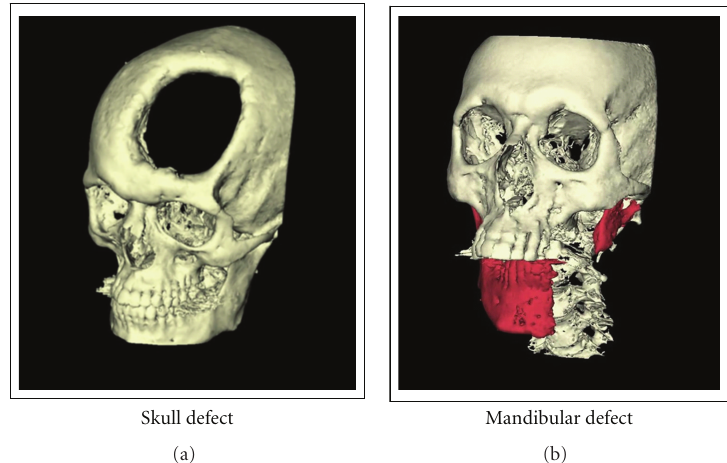
Figure 1: 3D reconstruction of a skull and mandibular defect in trauma patients. Surgeons are often faced with patients having large defects in the bone which do not heal spontaneously. The gaping hole in the skull and the area highlighted in red in the mandible are examples of large-sized defects in real patients. Though autografts are the gold standard treatment for such patients, the amount of graft material required is often the limiting factor. Tissue regeneration using synthetic or natural sca ff olds seeded with mesenchymal stem cells can be an alternative solution for such patients.